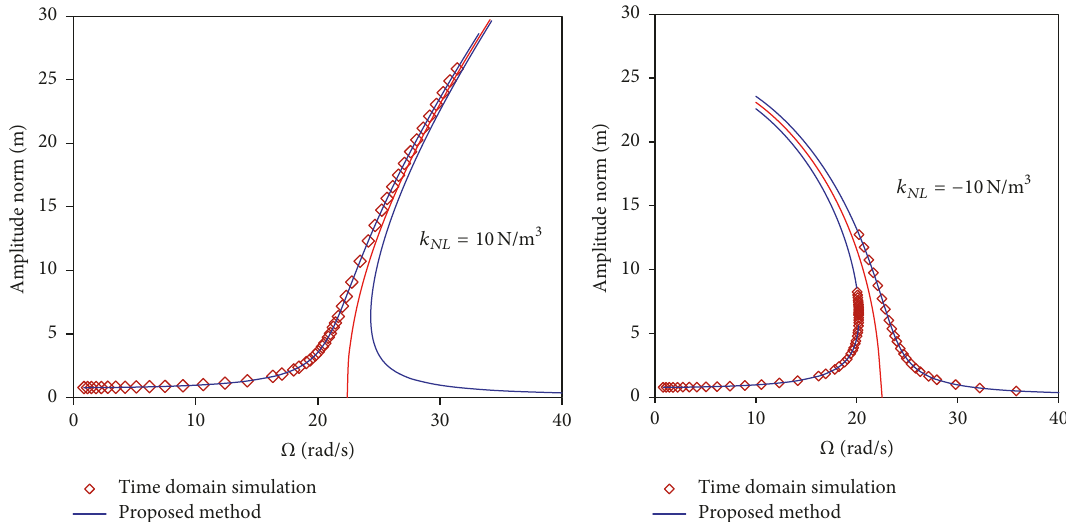
Figure 4: Nonlinear resonance curves. Maximum amplitude as a function of the forcing frequency.